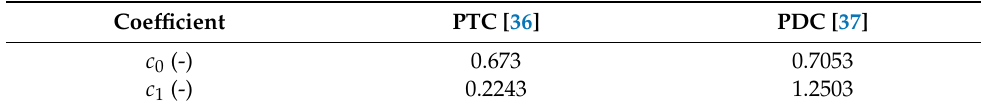
Table 2. Collectors’ efficiency coefficients for each type of